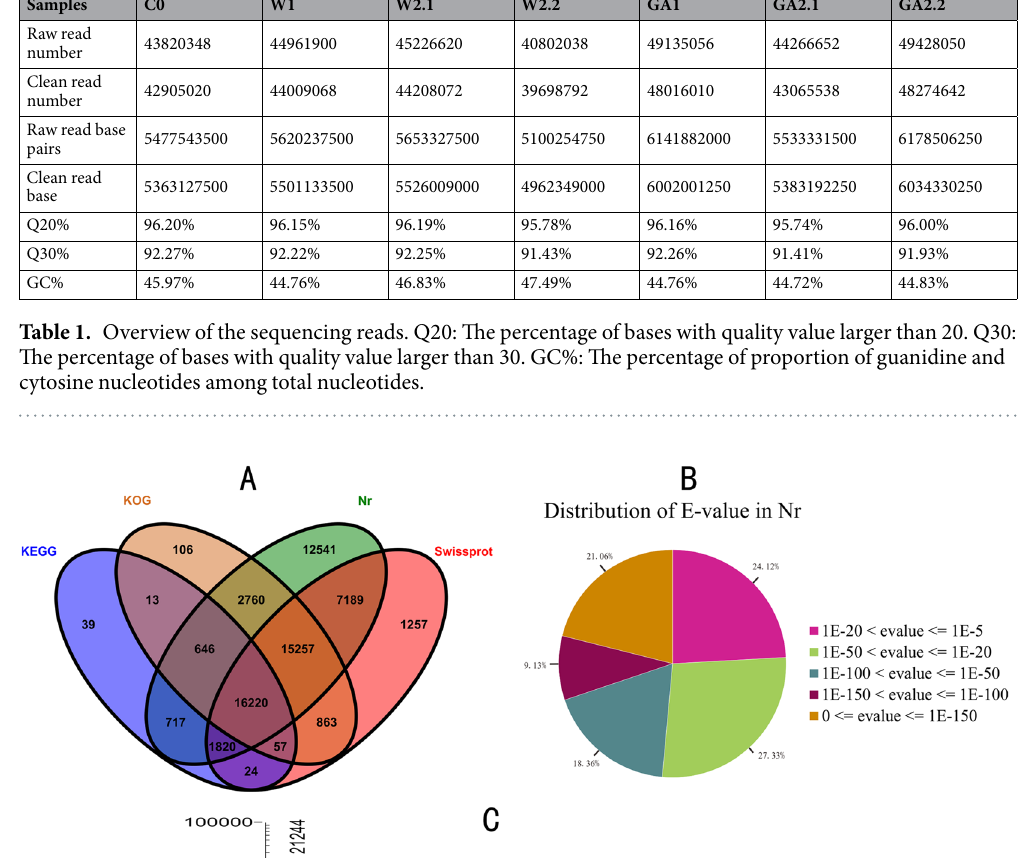
25 categories (Figure S3) Identification of differentially expressed genes (DEGs). To assess the normality of the RNA-Seq data